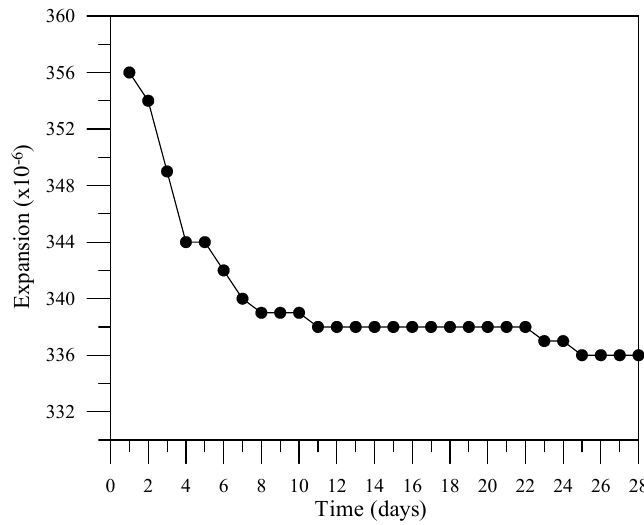
Figure 7. Expansion curves as a function of time.